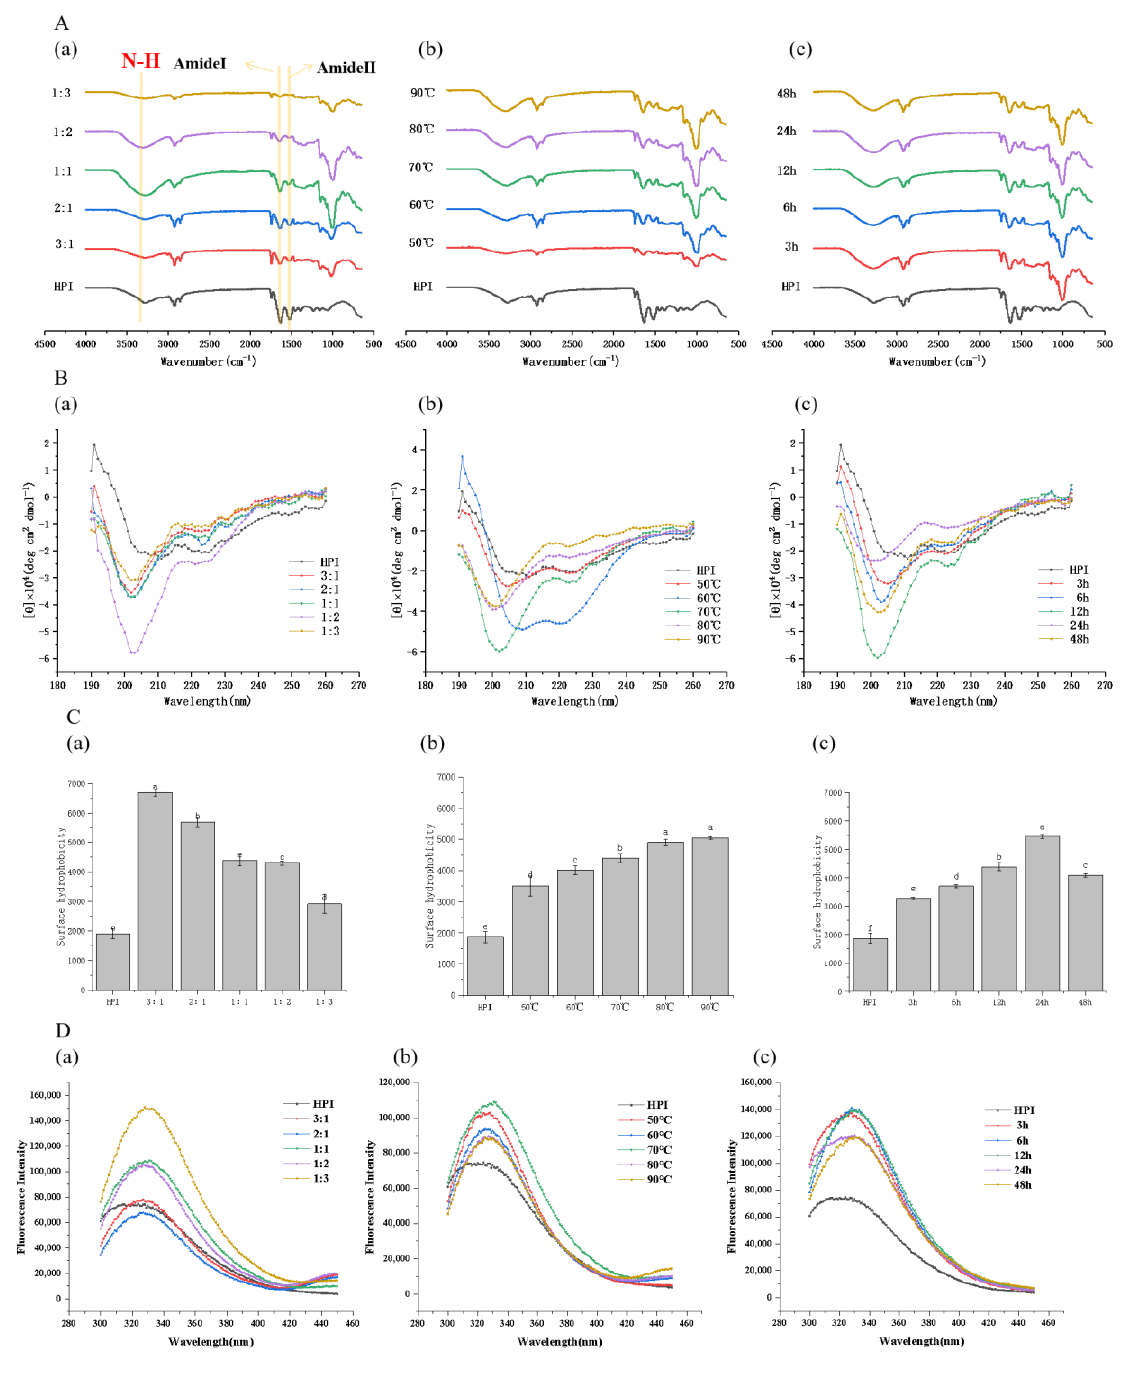
Figure 3. Effect of pullulan, ratios to hemp protein isolate (HPI), incubation temperature, and incubation time on spectroscopic analysis of glycosylated HPI: ( A ) FT-IR spectrum of HPI and HPI– pullulan conjugate; ( B ) secondary structure of HPI and HPI–pullulan conjugate; ( C ) the surface hydrophobicity (H0) of HPI and HPI–pullulan conjugate; ( D ) intrinsic fluorescence emission spectra of HPI and HPI–pullulan conjugate. ( a ): material feeding ratio (pH 7.0 and heated at 70 °C for 12 h); ( b ): reaction tempetature (pH 7.0 and heated 12 h with a HPI to pullulan ratio of 1:1); ( c ) reaction time (pH 7.0 and heated at 70 °C with a HPI to pullulan ratio of 1:1). Different superscript letters represent a significant difference ( p < 0.05).